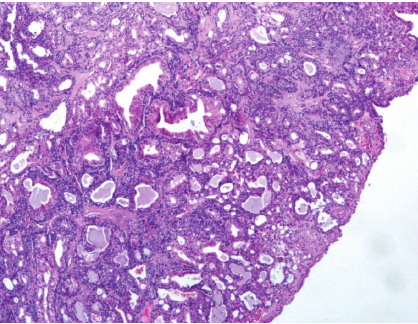
Figure 2: H/E × 40. The tumor is made of tubular and cystic structures.